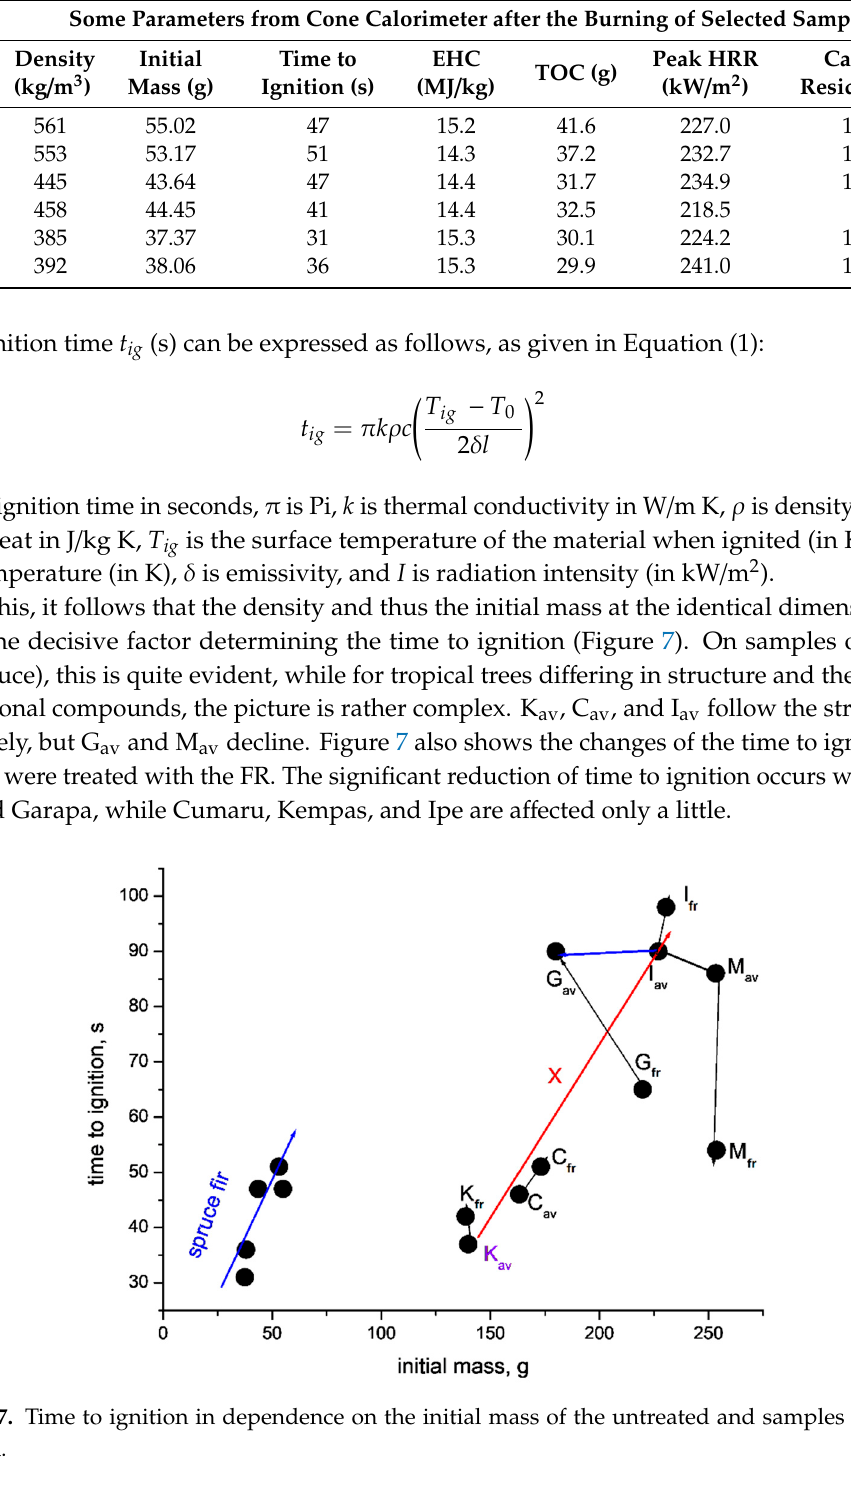
Table 5. Some parameters from the cone calorimeter after the burning of selected samples of spruce fir di ff ering in initial density (dimensions of samples at 9 × 9 × 1 cm) with a cone radiancy of 35 kW / m 2 .